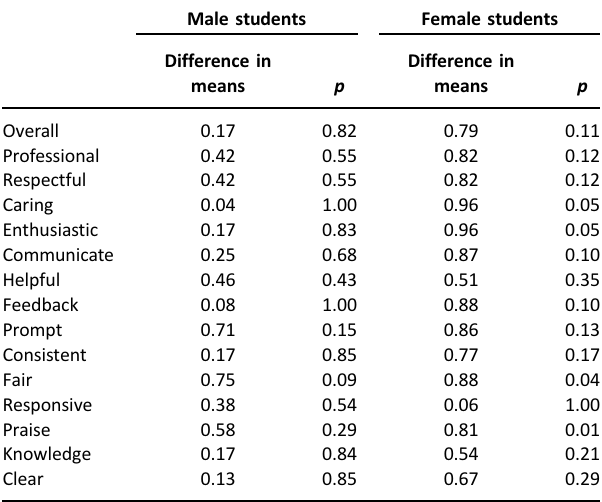
Table 9. SET and reported instructor gender (male minus